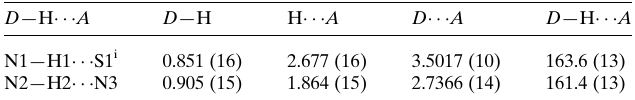
Table 1 Hydrogen-bond geometry (A˚ , (cid:4) ) for 1 .